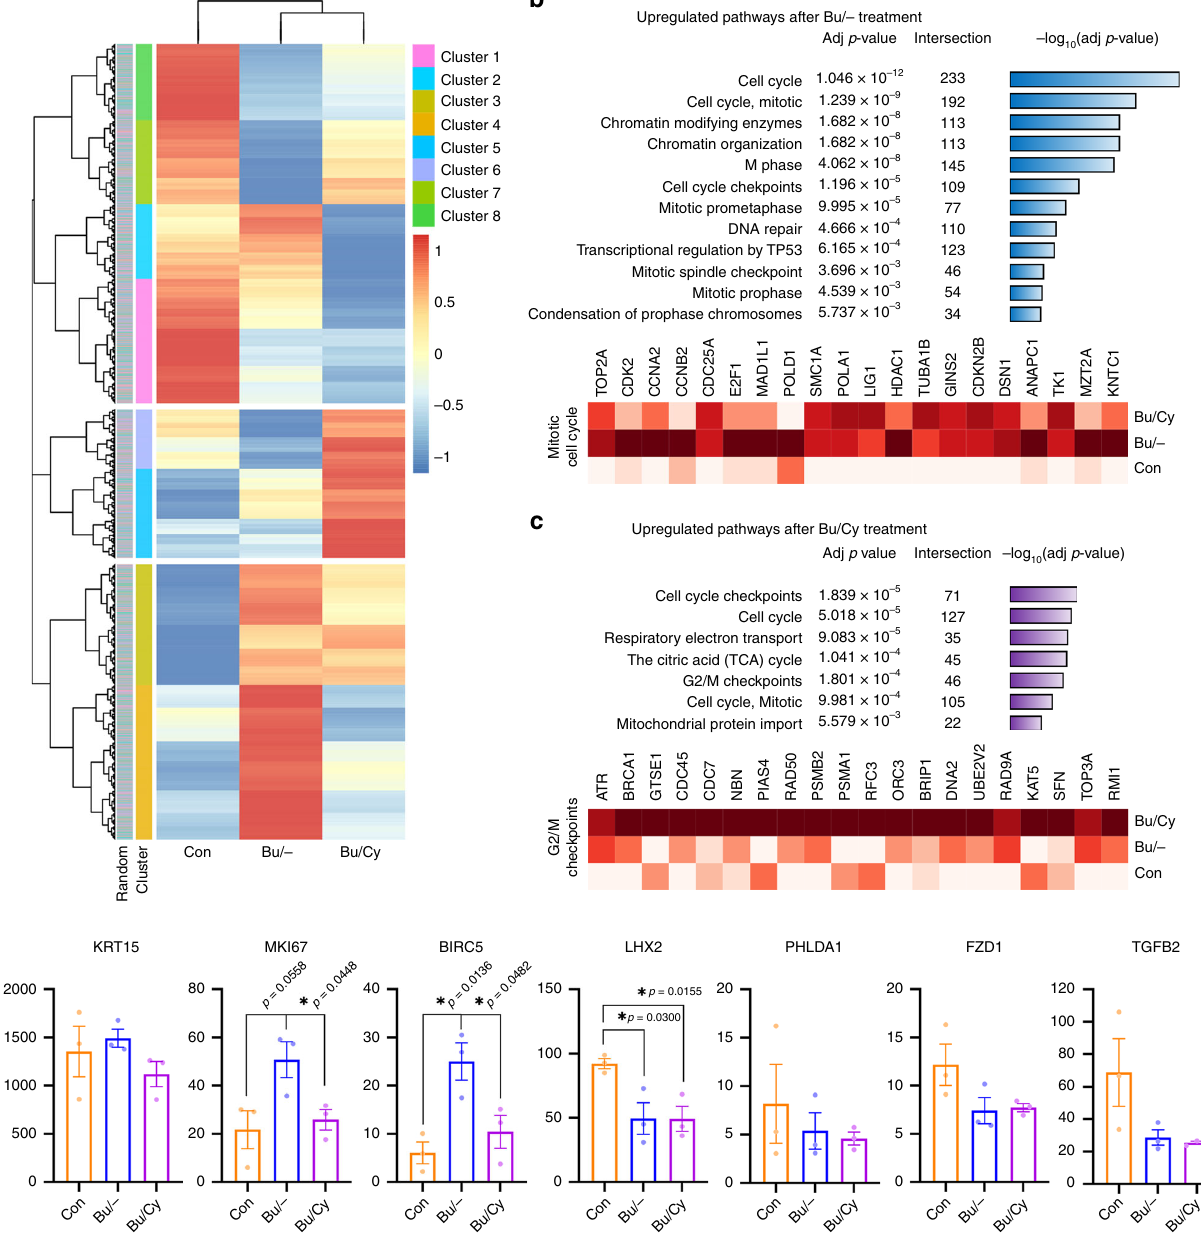
Fig. 8 Global gene expression changes of in vivo HFSCs after Bu/Cy treatment. a Hierarchical clustering and heatmap analysis of the 15855 gene expressions from RNA-seq of laser capture microdissected HFSCs ( n = 3 biological replicates/group). Based on the hierarchical clustering, the upregulated genes after Bu or Bu/Cy treatment were selected for the functional enrichment pathway analysis. b Selection of upregulated pathways from the Reactome database after Bu treatment (on day 4; clusters 3, 4). Expression heatmap of representative genes intersecting with the mitotic cell cycle pathway. c Selection of upregulated pathways from the Reactome database after Bu/Cy treatment (on day 7; clusters 5, 6). Expression heatmap of representative genes intersecting with the G2/M checkpoints pathway. d Expression of representative genes showing the key characteristics of human HFSCs including KRT15 (for HFSC marker), MKI67 (for Ki67), BIRC5 (for Survivin), LHX2 , PHLDA1 , FZD1 , and TGFB2 (for HFSC stemness) ( n = 3 biological replicates/group). Bu busulfan, Cy cyclophosphamide, Bu/Cy busulfan followed by cyclophosphamide; HFSC, hair follicle stem cell. Data are mean ± SEM. Source data are provided as a Source Data fi le. * p < 0.05 (unpaired t-